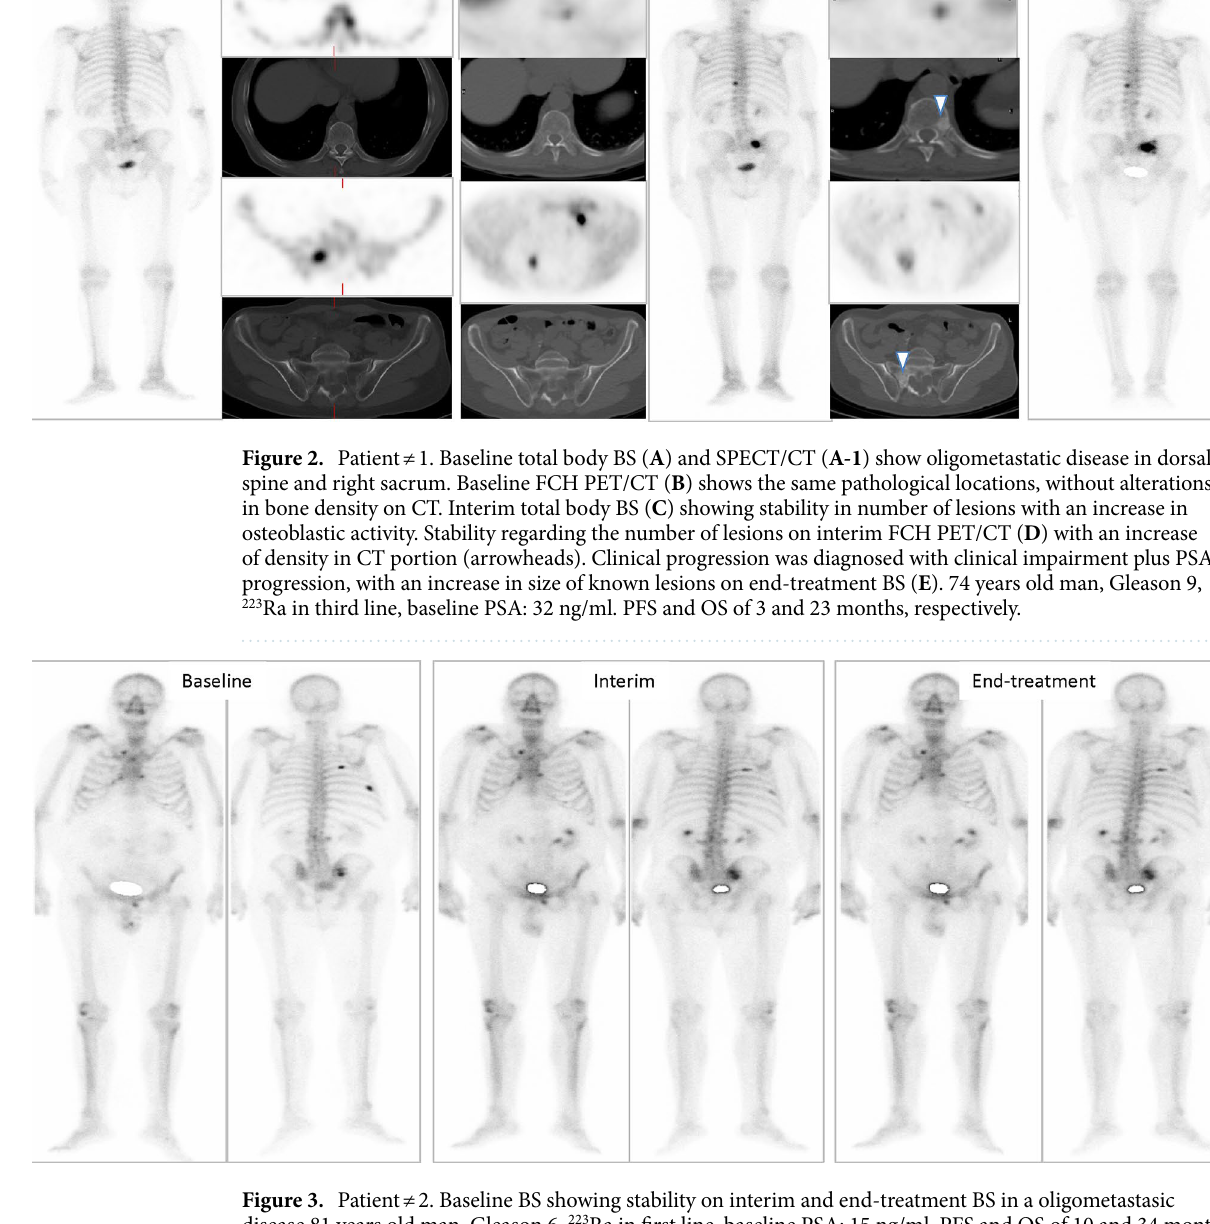
Figure 3. Patient ≠ 2. Baseline BS showing stability on interim and end-treatment BS in a oligometastasic disease 81 years old man, Gleason 6, 223 Ra in first line, baseline PSA: 15 ng/ml. PFS and OS of 10 and 34 months,